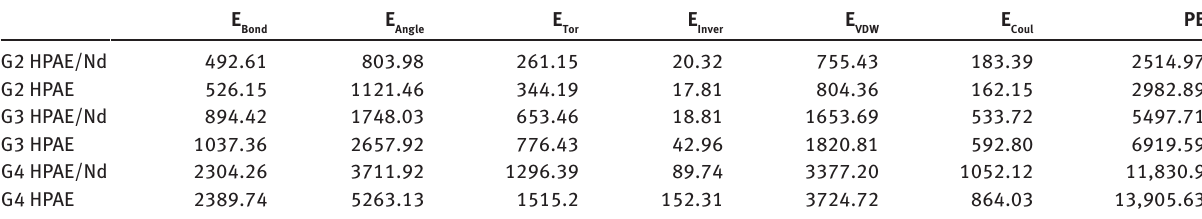
Table 4 Energies of G2–G4 HPAE systems (KJ/mol).